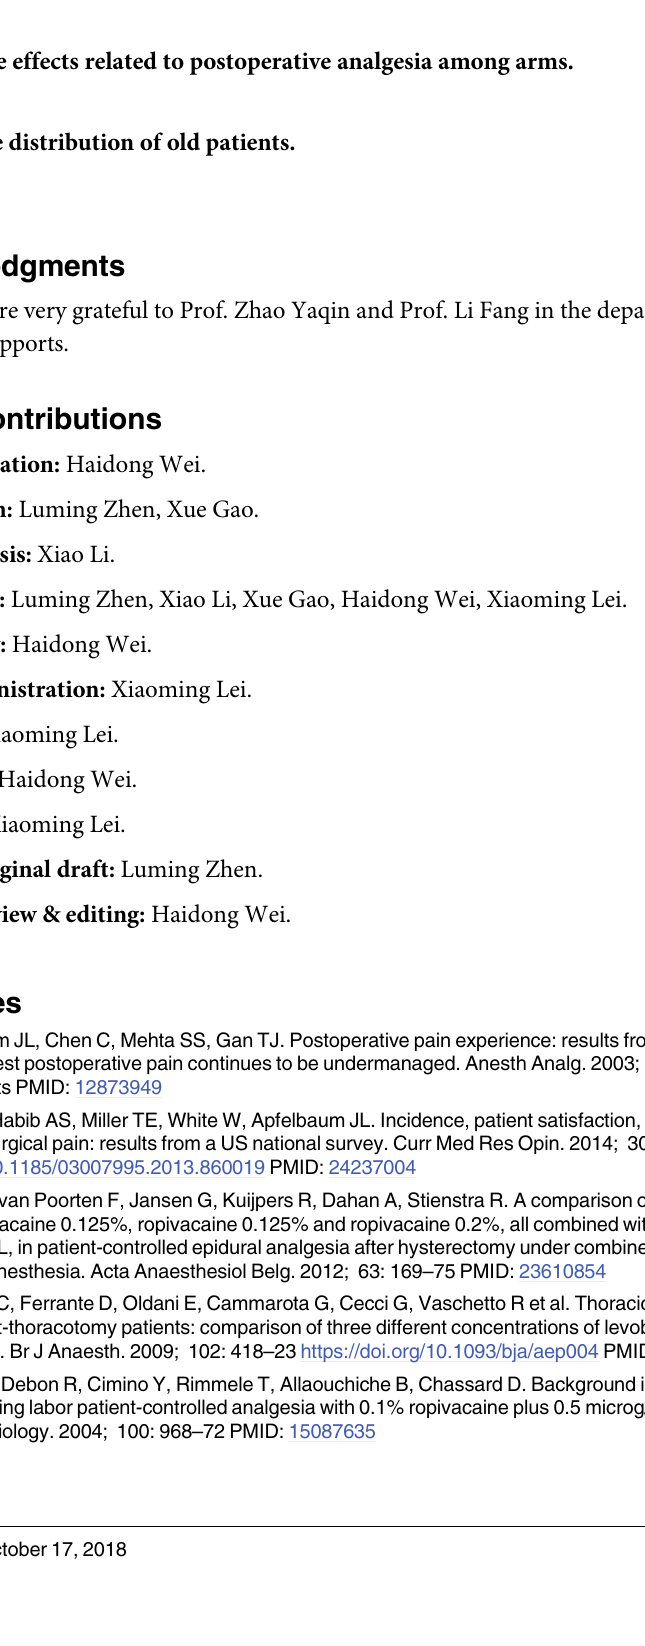
S1 Table. Side effects related to postoperative analgesia among arms. S2 Table. Age distribution of old